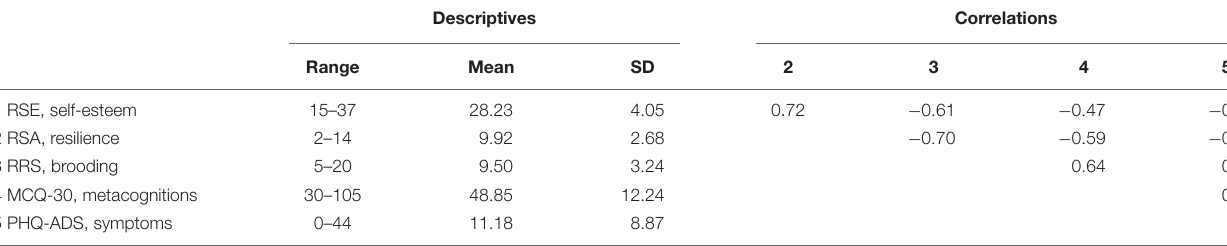
TABLE 1 | Descriptive statistics and bivariate correlations among variables ( n = 725).